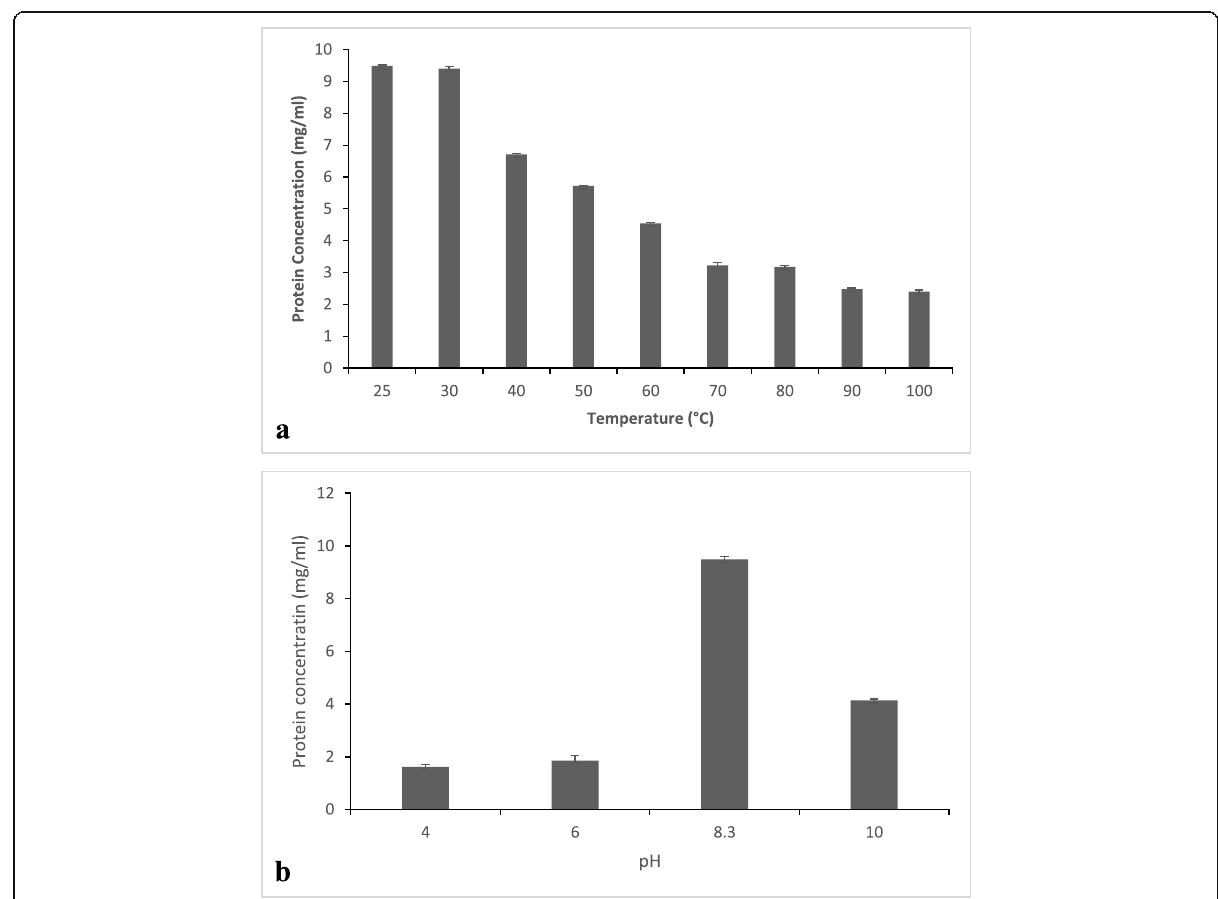
Fig. 1 Protein concentration of the crude extracts of Dioscorea bulbifera a at different temperature and b at different